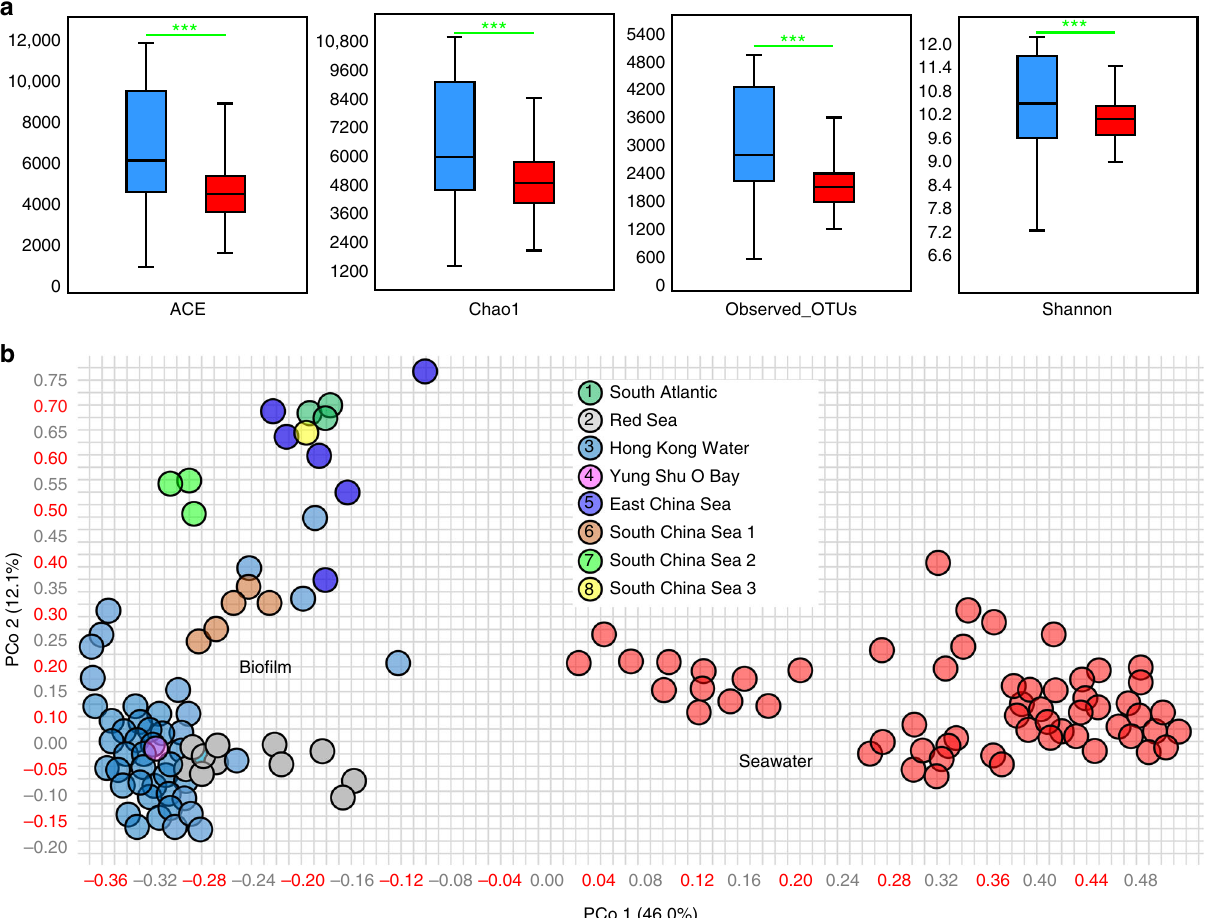
Fig. 3 Alpha- and beta-diversity. a ACE, Chao1 diversity, and observed OTUs are signi fi cantly different between the bio fi lm-associated (blue) and seawater- derived (red) microbial communities. *** p -value < 0.001 (two-tailed Student ’ s t -tests after Shapiro – Wilk test to con fi rm the normal distribution of these data). In a boxplot, central line represents the median, bounds represent upper and lower quartiles, and whiskers represent maximum and minimum. b Jaccard similarity of the microbial communities illustrated by PCoA of the OTU matrix. These analyses were performed after normalizing the different metagenome-derived 16S rRNA gene data to the same library size, i.e. 10,000 sequences per